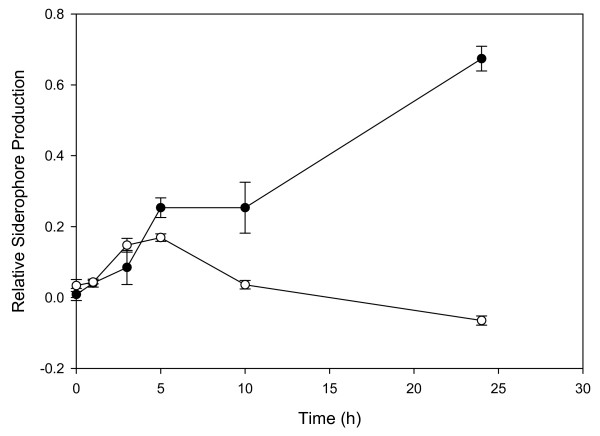
Relative siderophore production by wild-type MR-1 and Δso2426 mutant cells under chromate conditions. A final chromate concentration of 0.3 mM was added to mid-log-phase (OD600, 0.5) wild-type MR-1 (●) and Δso2426 mutant (○) cultures cultivated in LB broth, and relative siderophore synthesis by each culture was monitored over time using the CAS assay. The relative siderophore production was calculated by subtracting the supernatant A630 for the wild type or mutant from the uninoculated control and then determining the ratio of corrected supernatant A630 to control A630. The graphed values represent mean ratios ± standard errors (bars) for three replicate CAS measurements.